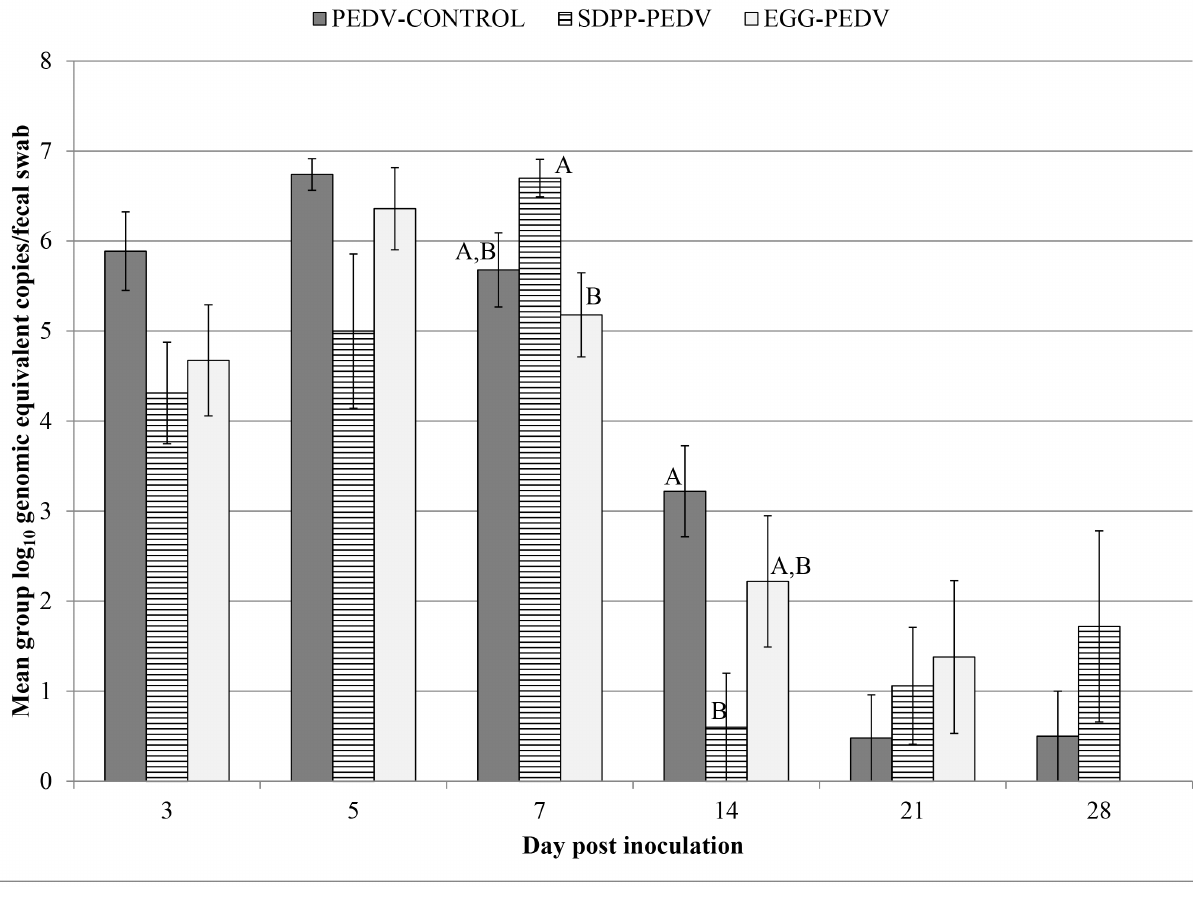
Figure 2. Group mean PEDV RNA levels in fecal samples over time. Group mean log 10 PEDV RNA levels ( 6 SEM) were determined in fecal samples from PEDV-infected pigs (PEDV-CONTROL, SDPP-PEDV, EGG-PEDV) collected from day post inoculation (dpi) 3 through 28. The data were analyzed by one-way ANOVA method followed by Tukey’s pairwise test using the JMP software version 10.0.2 (SAS Institute, Cary, North Carolina, USA). Different superscripts ( A,B ) indicate significant different group means on selected days (p , 0.05).